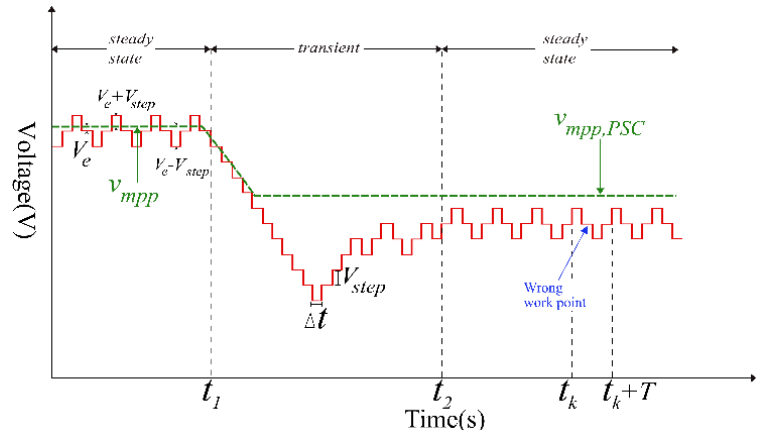
Figure 6. The tracking process of the conventional P&O.